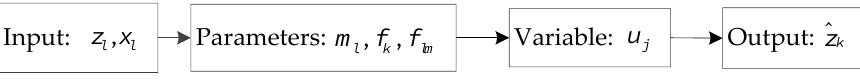
Figure 3. Non-uniform fast Fourier transform (NUFFT) diagram.